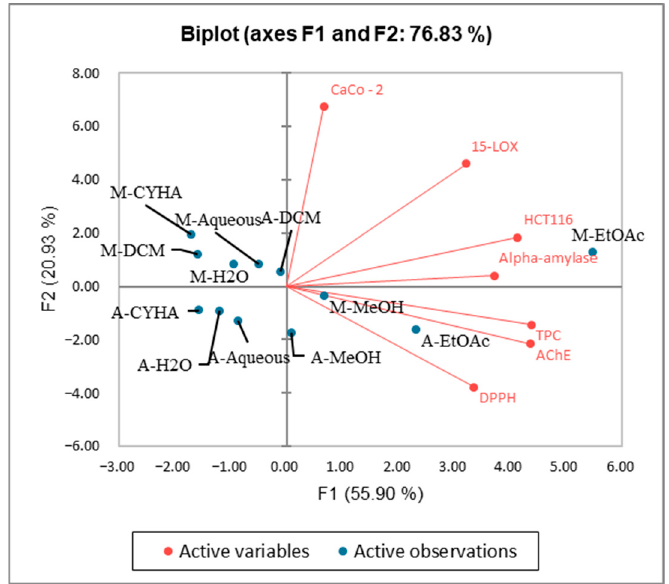
Figure 12. Principal Components analysis “Biplot” of (DPPH: Antioxidant activity) (TPC: total phenolic content) and biological activities (Alpha amylase: Antidiabetic activity); 15-LOX: Anti-inflammatory activity); (HCT-116 and Caco-2: cytotoxic activity) and (AChE: anti-Alzheimer activity) of V. vinifera stem extracts.